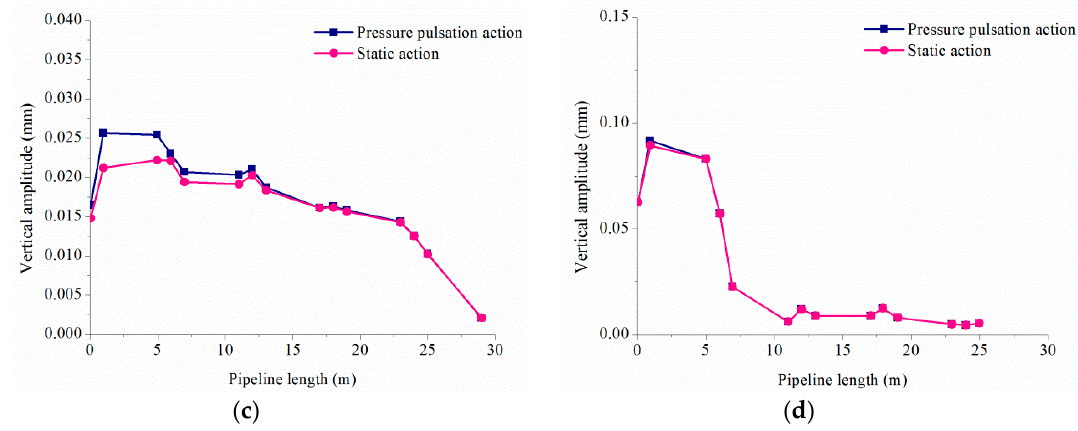
Figure 21. Vertical amplitude of pipes: ( a ) RP1 pump outlet pipe; ( b ) RP1 pump inlet pipe; ( c ) main outlet pipe; ( d ) main inlet pipe. Table 7. Summary of the maximum amplitude and location.